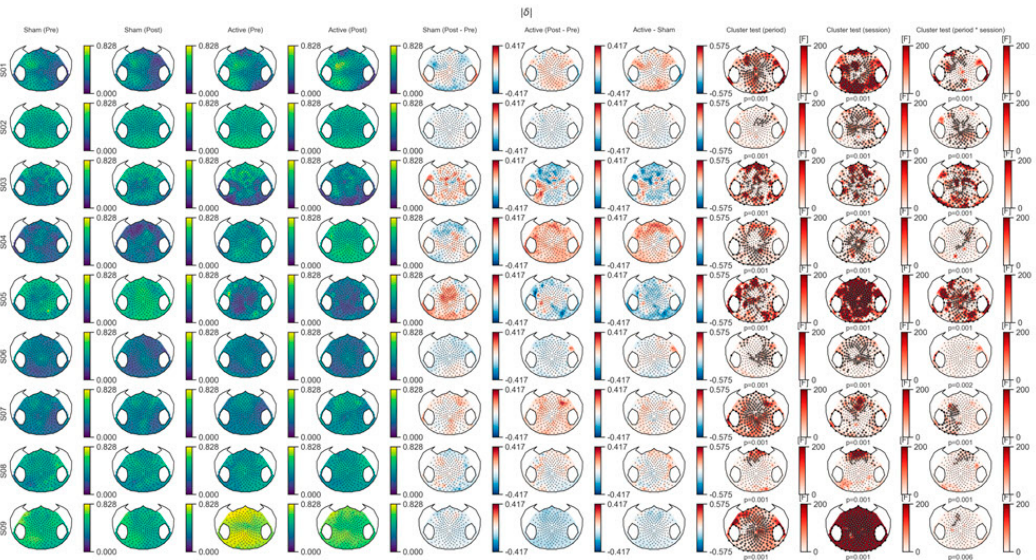
Figure A1. Spectral Power Variability of the Delta Band at the Subject Level. The first four columns show the mean power over the epochs for each session and period. Columns 5 and 6 show the power difference in the sham and active sessions respectively. Column 7 shows the differences between active and sham sessions (i.e., (post-pre) Active– (post-pre) sham ). Columns 8 to 10 show the results of the permutation cluster test on the F values of the ANOVA model to test the significance of the effects of period (post vs. pre), session (sham vs. active), and their interaction, respectively.